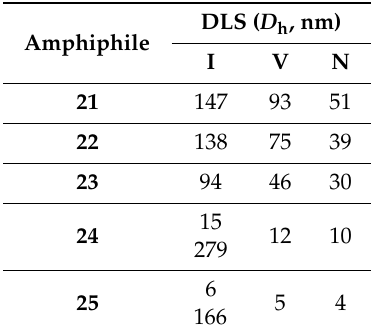
Figure 3. Cryo-TEM image of amphiphile 25 showing micellar assembly (indicated by arrows) and surface contamination (indicated by white circles) at different